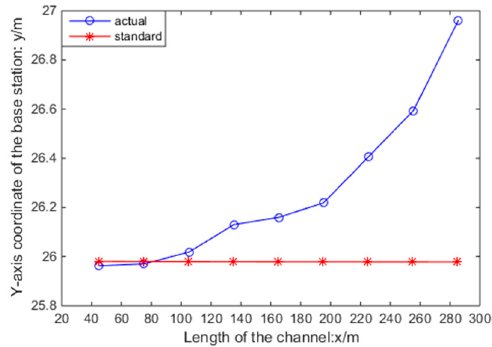
Figure 14. Error variation chart as base station location changes (another side).